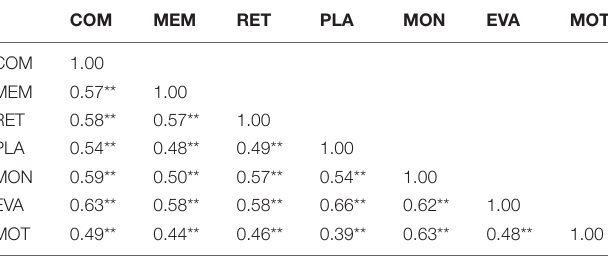
TABLE 2 | Correlation matrix of the strategy use